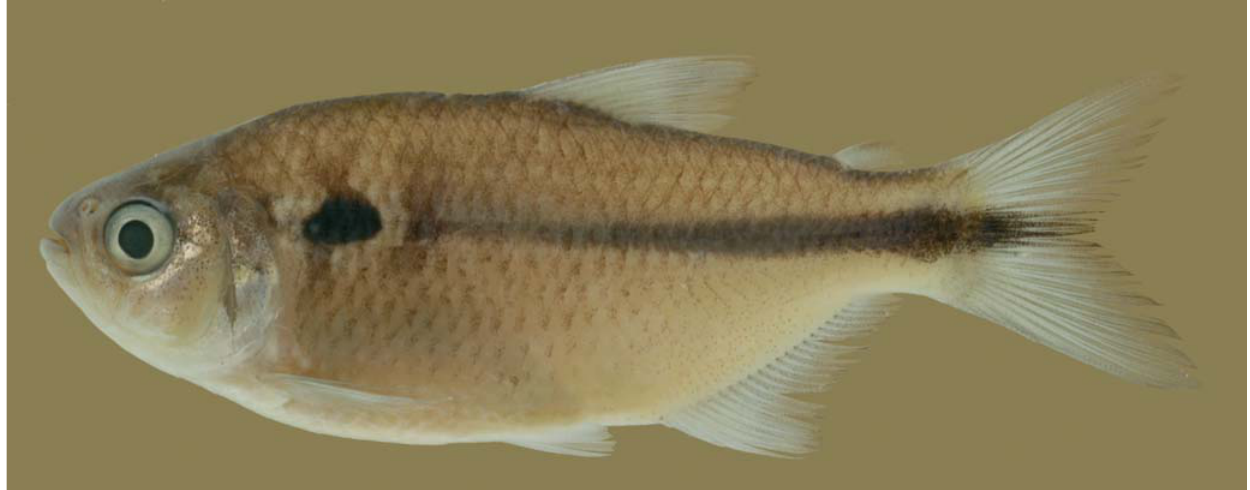
Fig. 1. Astyanax goyacensis Eigenmann, DZSJRP 10857, topotype, 75.2 mm SL, rio Vermelho, Municipality of Goiás, Goiás State, rio Araguaia basin (upon capture).